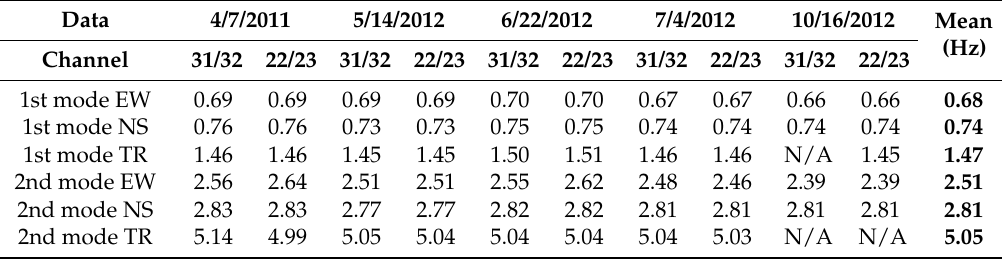
Table 2. Natural frequencies of the Building identified using data from the accelerometer array.